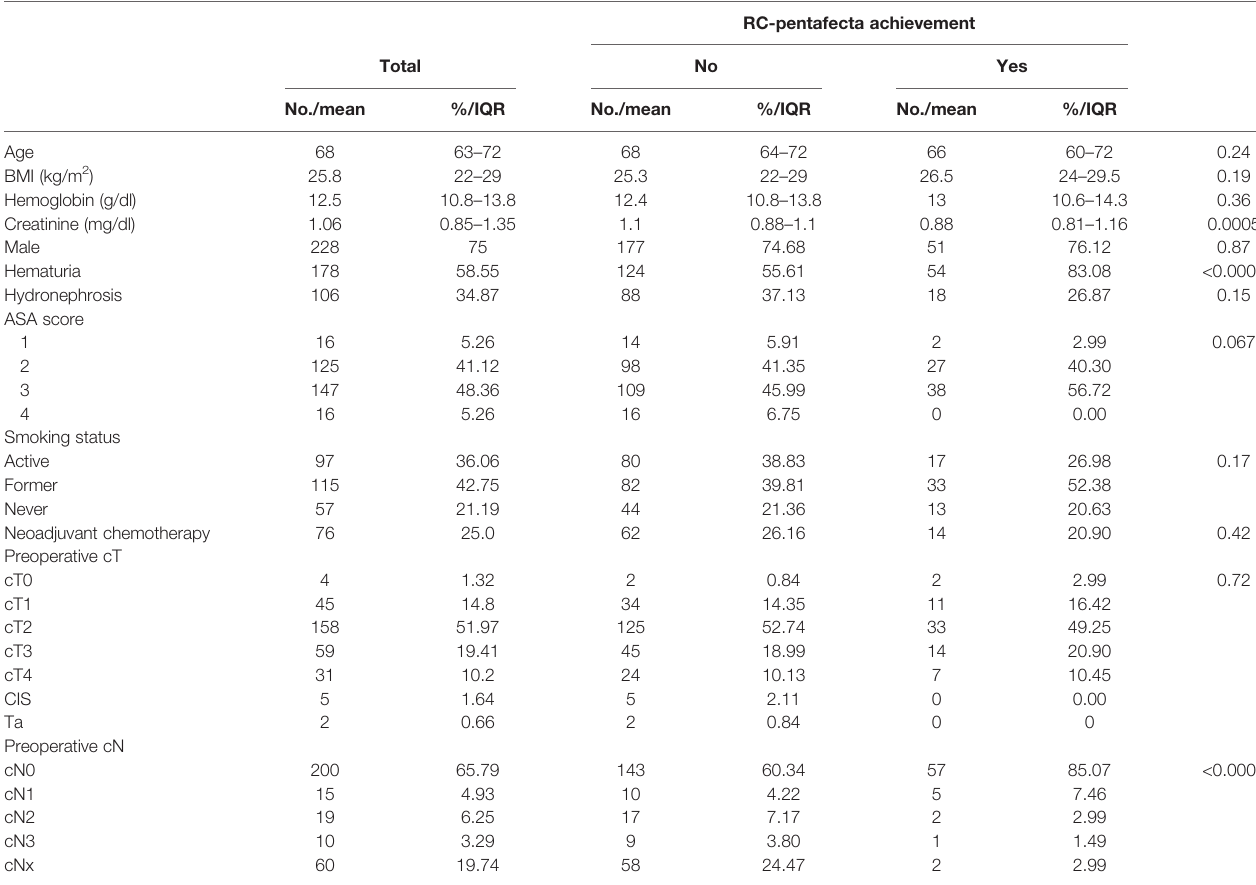
TABLE 1 | Baseline characteristics of patients who underwent RCs.